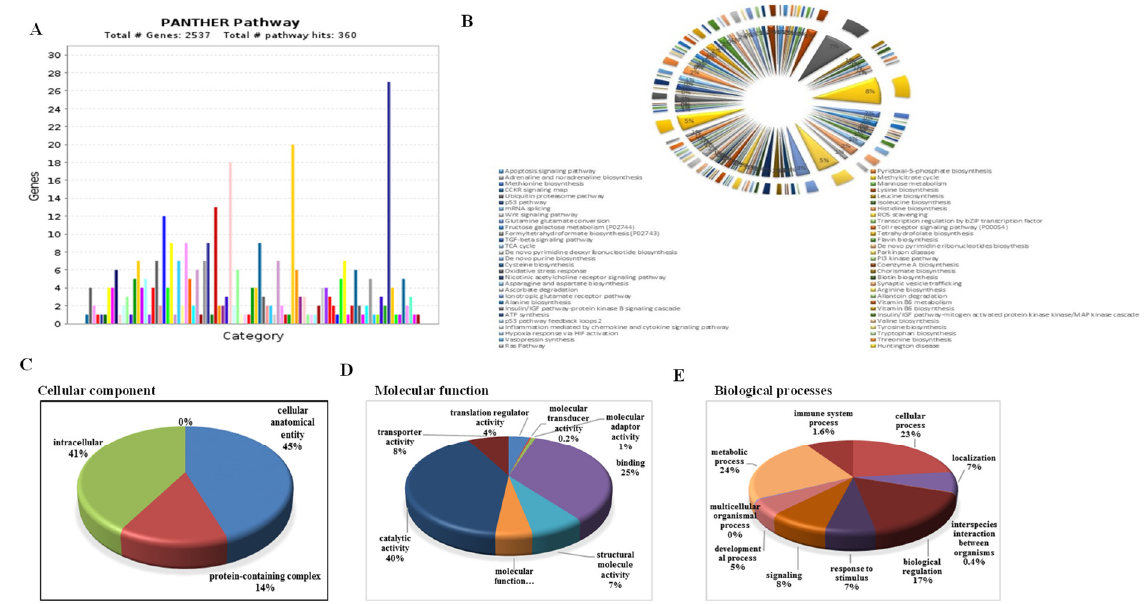
Figure 13. GO terms: ( A ) Gene Ontology classification of metabolic pathways, ( B ) frequency of highly abundant GO terms under the molecular function, biological process, and cellular component categories in Sorghum bicolor , ( C ) GO classification based on the cellular level, ( D ) GO Ontology classification based on molecular function, ( E ) GO classification based on biological processes.